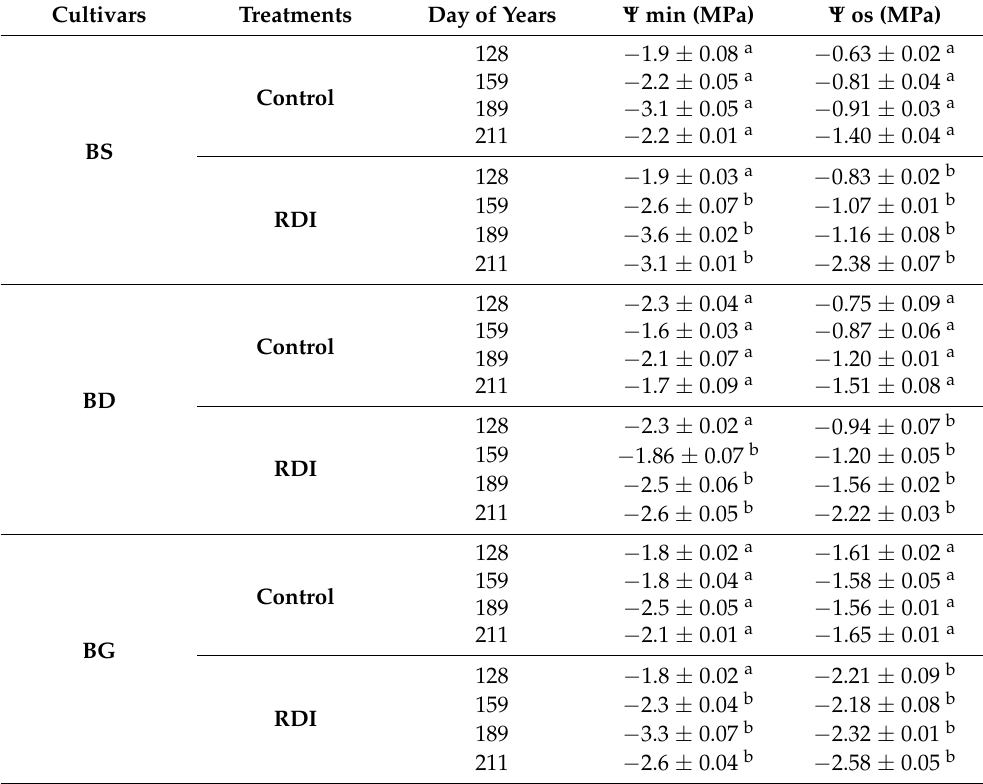
Table 2. Effect of regulated-deficit irrigation (RDI) on Midday leaf water potentials ( Ψ min (MPa)) and osmotic potentials ( Ψ os (MPa)) of three plum cultivars (Black Diamant, Black Gold, and Black Star) in the centre of Tun